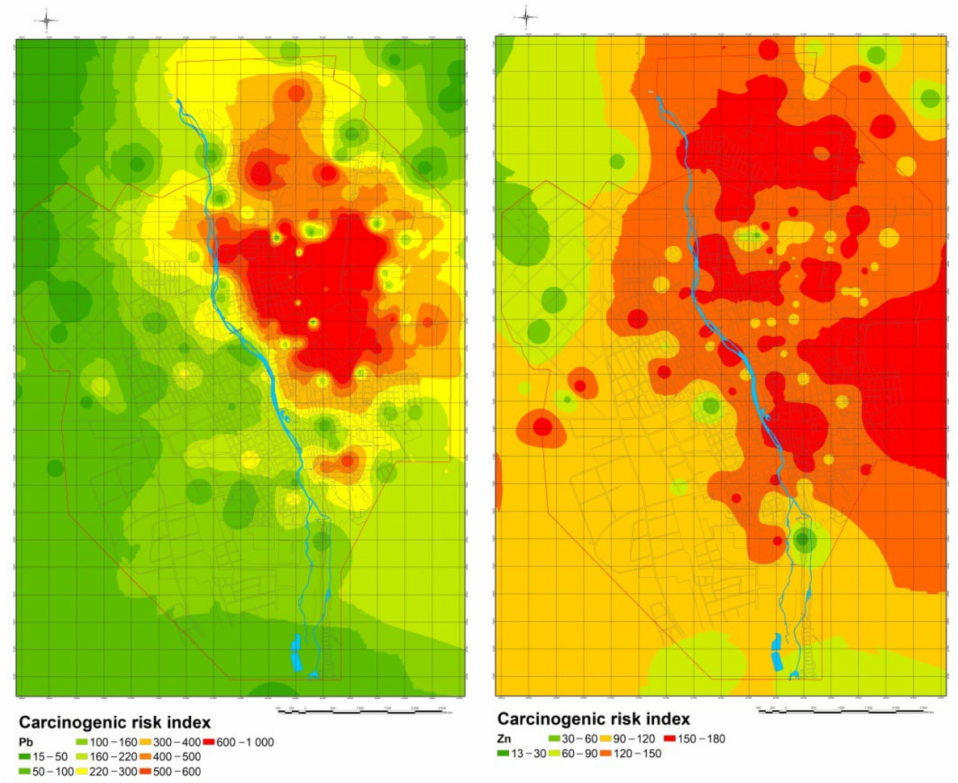
Figure 5. Carcinogenic risk index maps for lead and zinc for the territory of